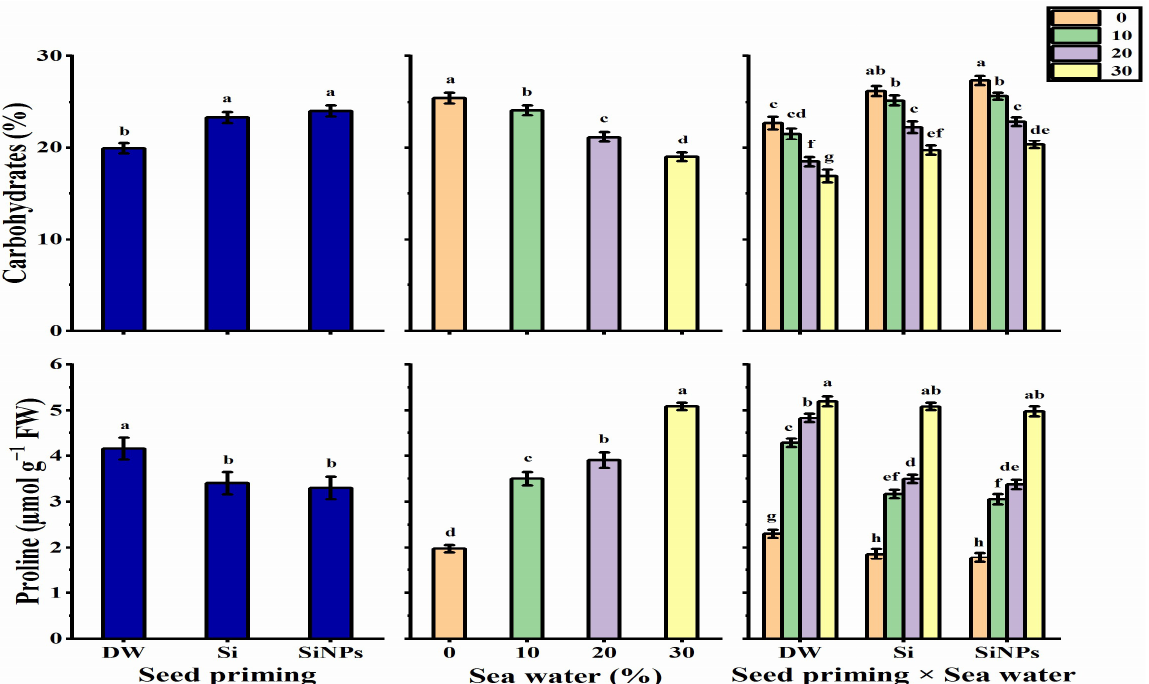
Figure 5. Effect of seed priming on carbohydrates (%) and proline ( µ mol g − 1 FW) contents of Lathyrus odoratus leaves irrigated with seawater levels (0, 10, 20, and 30%). Data are mean value ± SE. Bars with different letters are significantly different at p ≤ 0.05 level.